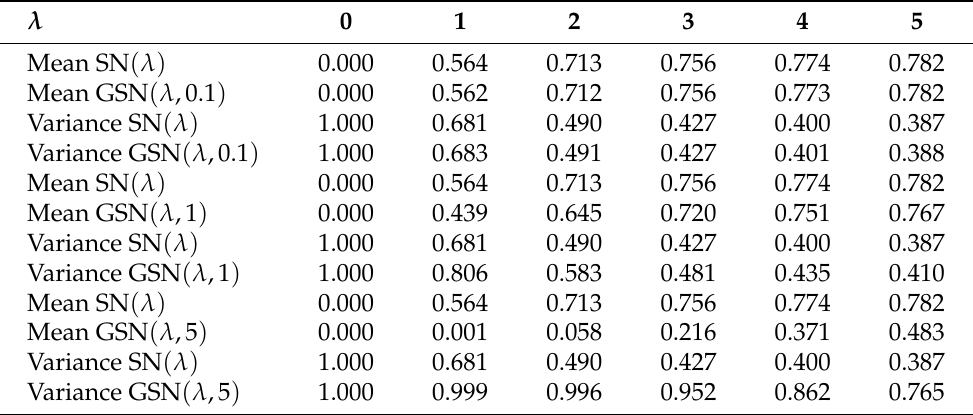
Table 1. Mean and variance of the GSN and the SN variates for some parameter values.